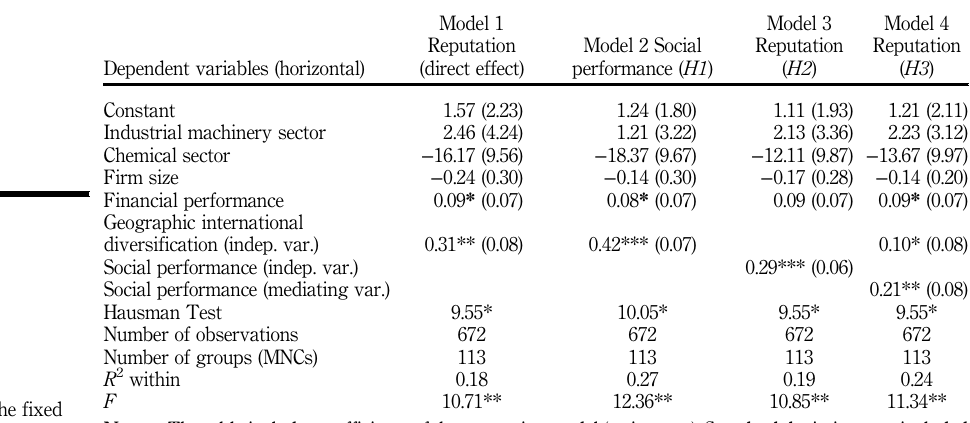
Table IV. Results of the fixed effects linear regression